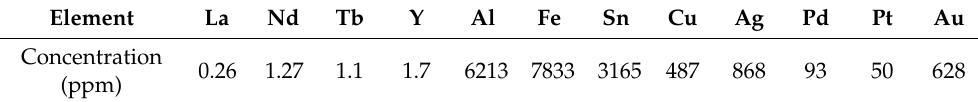
Table 1. The composition (ppm) of the semi-finished product from WEEE. Element